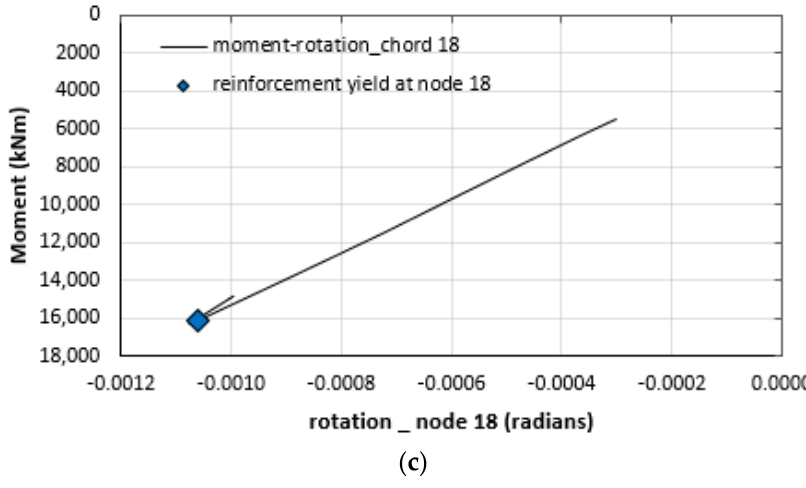
Figure 9. Moment rotation curve for nodes ( a ) 28, ( b ) 20 and ( c ) 18.